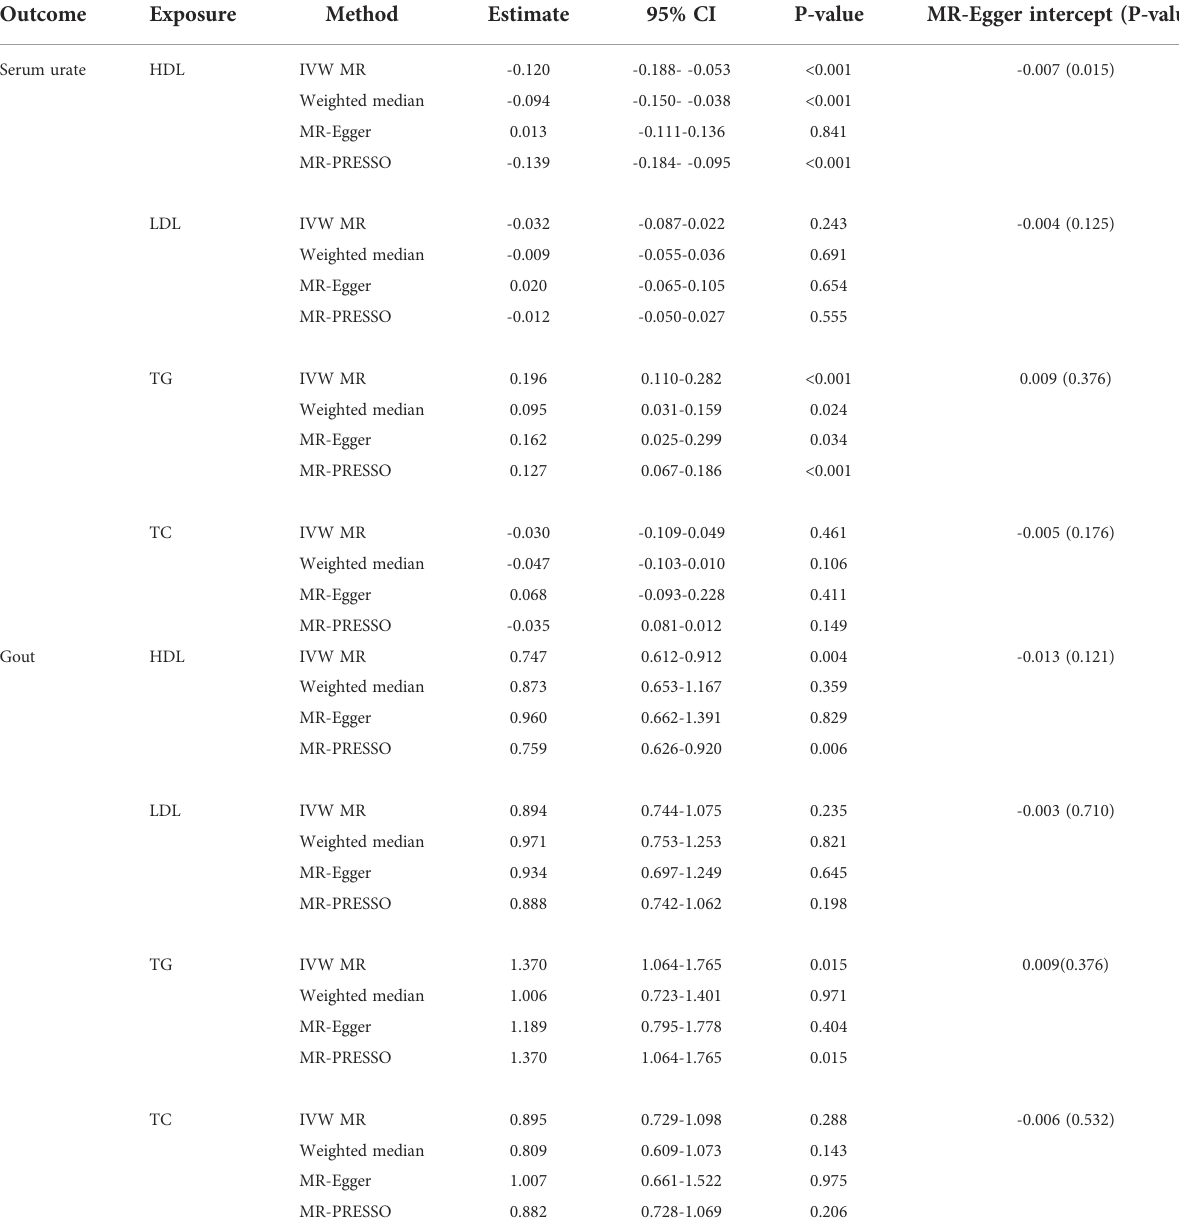
TABLE 4 Mendelian randomization estimates of blood lipid on serum urate or